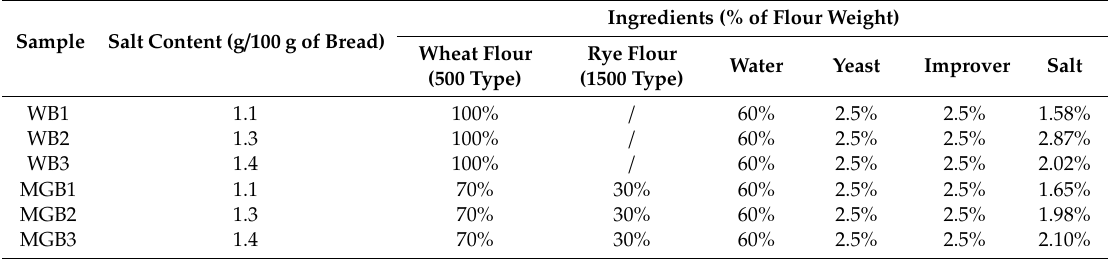
Table 1. Bread sample